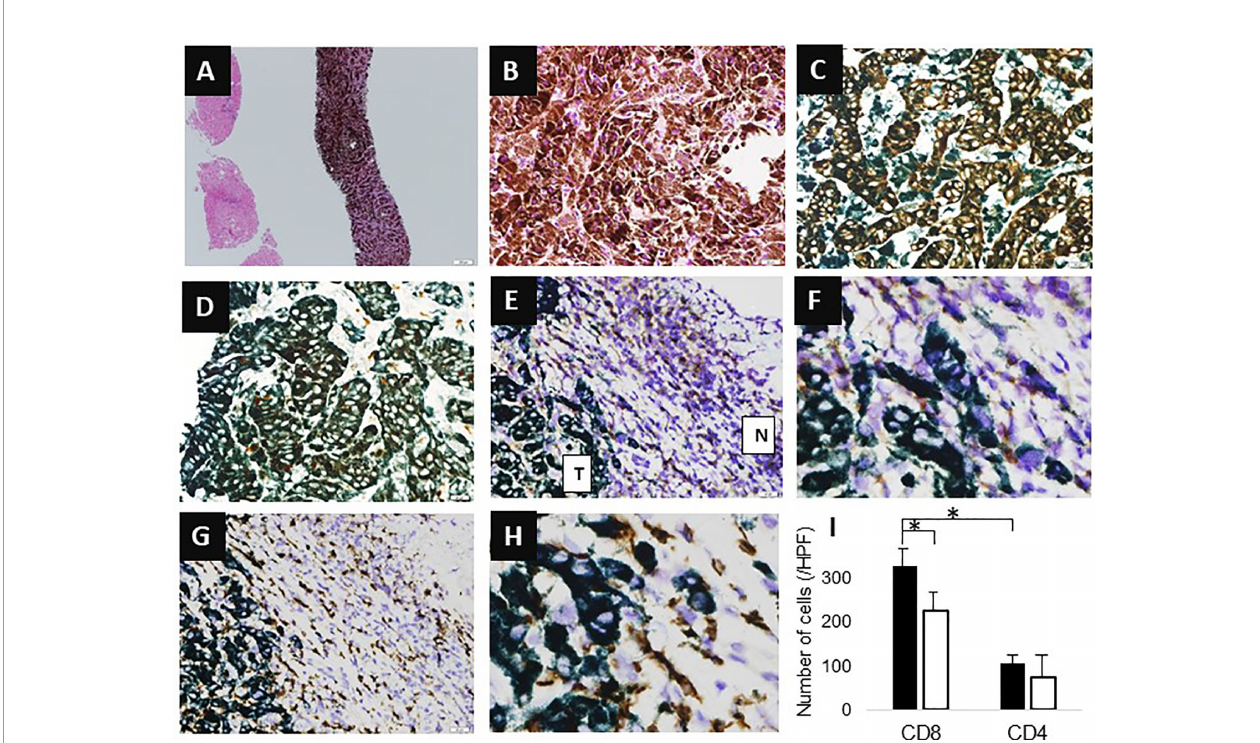
FIGURE 3 | Histological fi ndings. (A, B) Hematoxylin-eosin (HE) staining ( A , X4; B , X200). (C) Melan-A staining (X400). (D) MIB-1 staining (X400). (E, F) CD4 staining ( E , X100; F , X400); T indicates tumor area, N indicates non-tumor area. (G, H) CD8 staining ( G , X100; H , X400). (I) Number of in fi ltrating cells. Y-axis represents the number of in fi ltrating cells. The average number of cells in three high power fi elds is shown. Black bar means the number of cells in tumor area, whereas white bar means that of non-tumor area. Asterisk indicates statistical signi fi cance